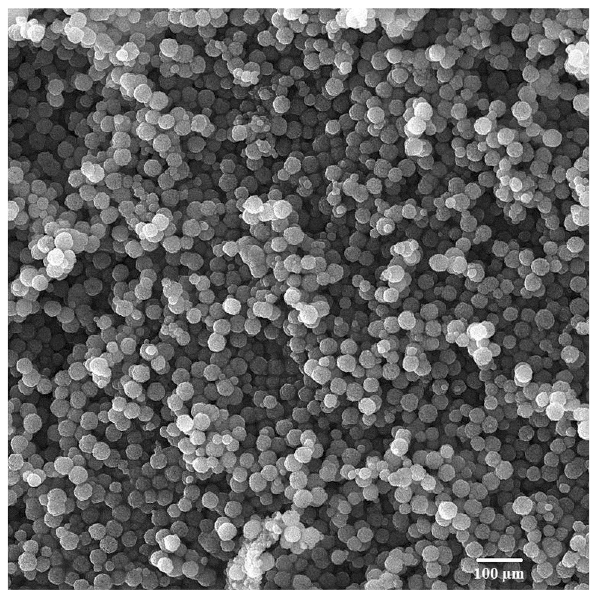
Figure 3. The CS with a concentration of 0.2% and 13.75 mg of DOX per ml of CS solution. The scanning electron microscope (SEM) of outcome CS + DOX microgel droplet of experimental result that the volumetric flow rate of CS + DOX phase was 3.3 mm/s and the volumetric flow rate of oil phase was 11.1 mm/s.